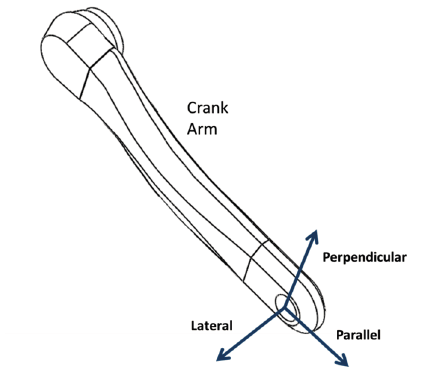
Figure 1. Components of the applied